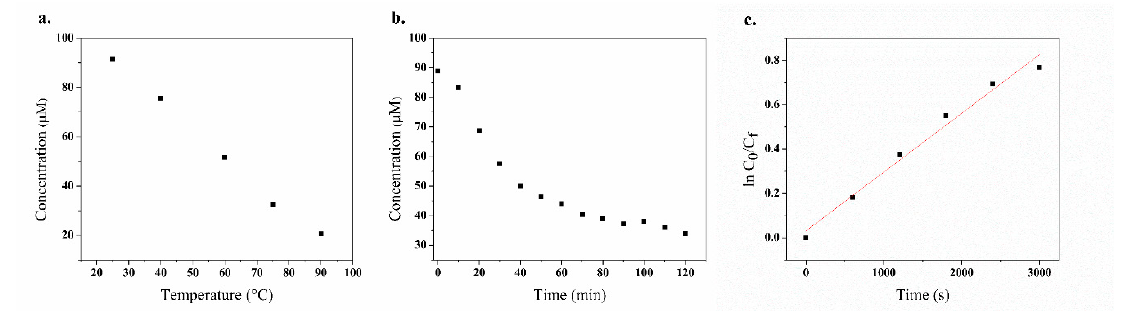
Figure 7. Degradation effect of temperature and UV radiation on mancozeb (MCZ). ( a ) Temperature, ( b ) time effect under UV light, and ( c ) pseudo-first-order plot for photodegradation, ln C 0 / C f